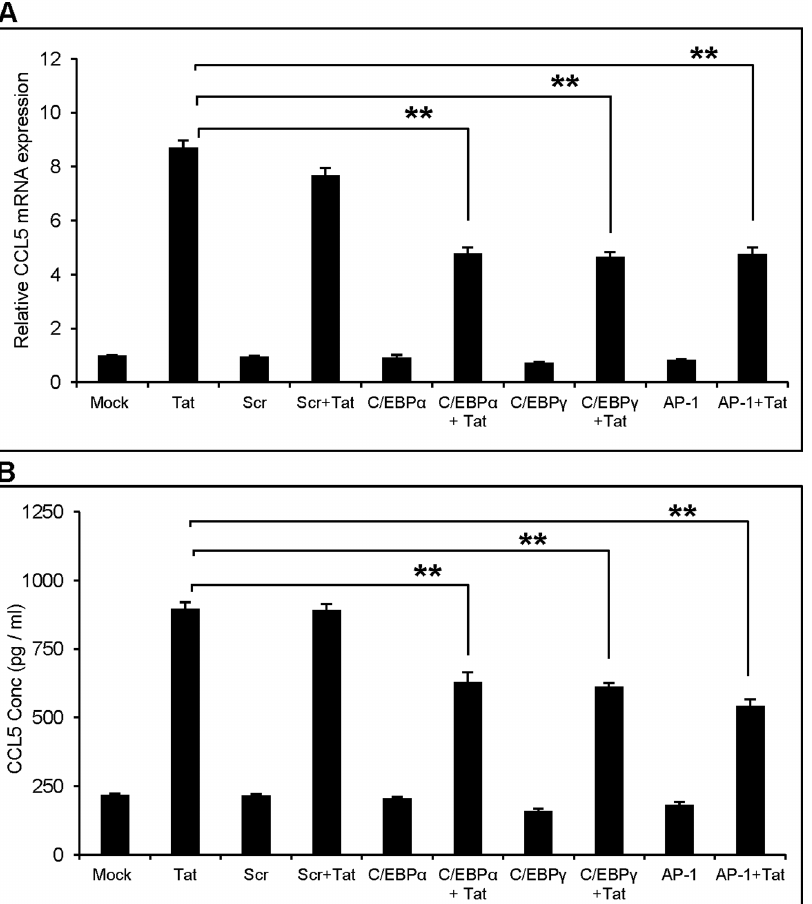
Figure 5. Involvement of C/EBP a , C/EBP c and AP-1 in HIV-1 Tat mediated induction of CCL5. SVGA astrocytes were transfected with siRNA against C/EBP a , C/EBP c and AP-1 (A, B) for 48 h before transfecting with HIV-1 Tat plasmid. The expression of CCL5 was measured at mRNA (A) and protein (B) levels. The values represented for mRNA are expressed relative to the mock-transfected controls. Each experiment was performed in triplicate and each bar in the figure represents the mean 6 SE of at least three individual experiments. One-way ANOVA was used to perform the statistical analysis and ** denotes p-value # 0.01.